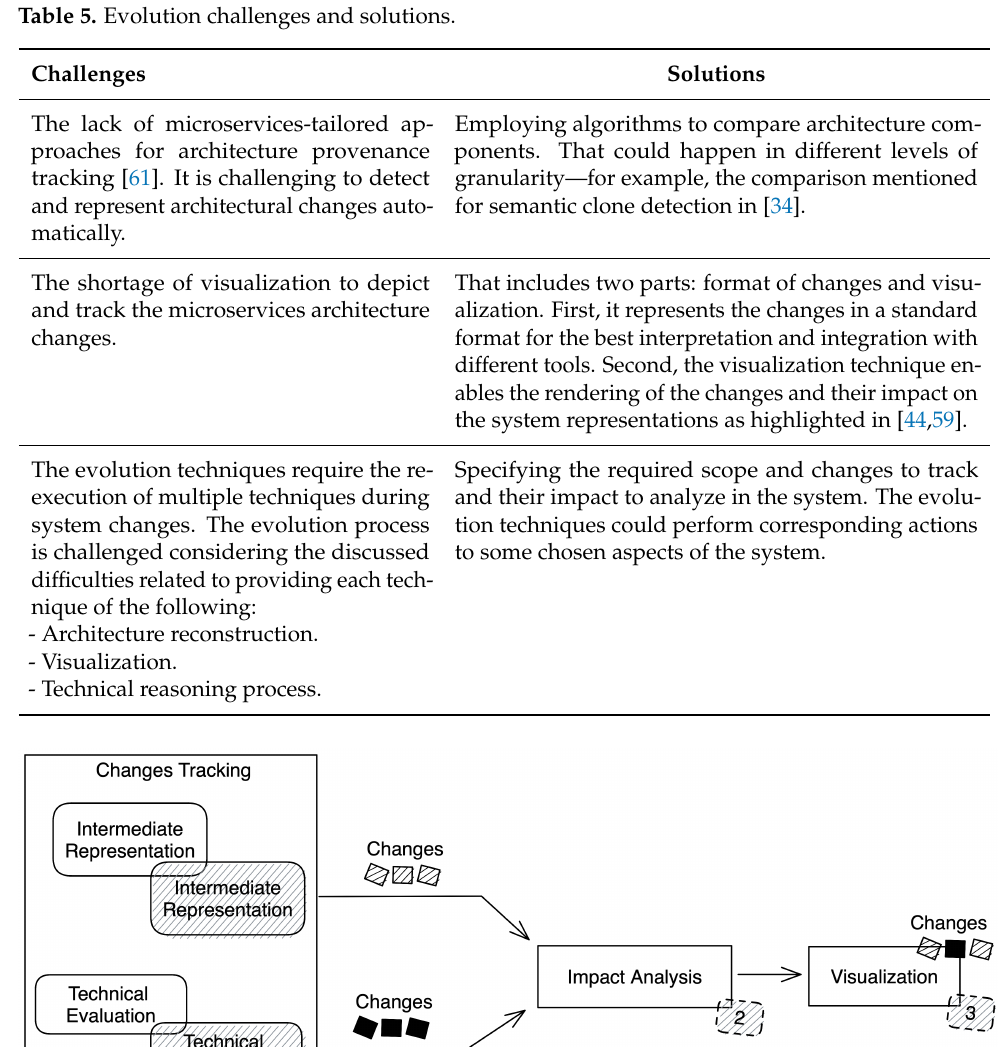
Table 5. Evolution challenges and solutions.